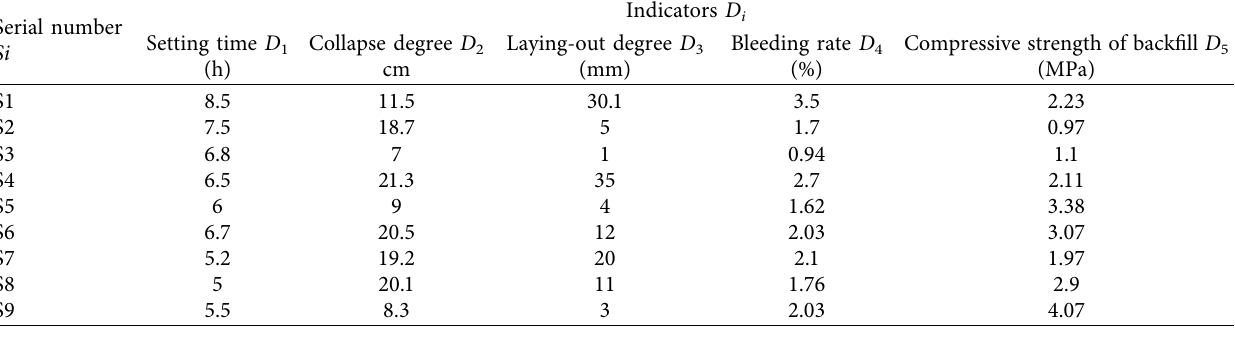
Table 4: Results of the setting time ( D